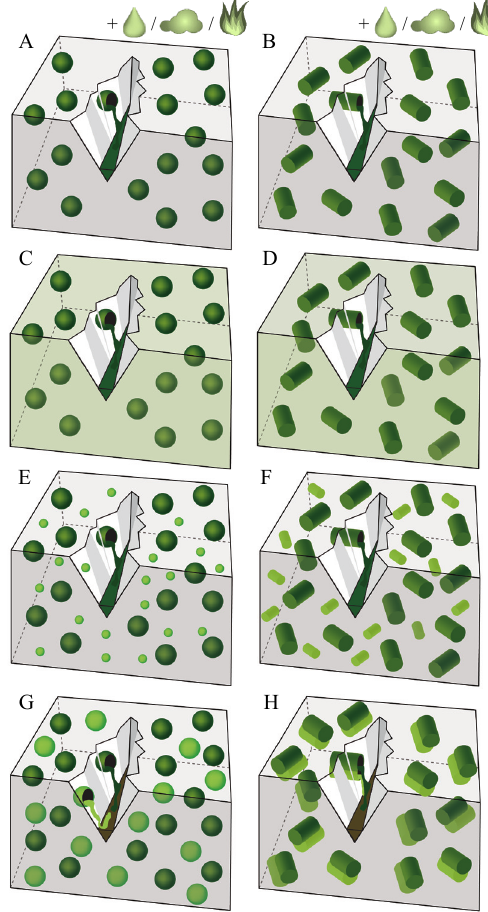
Figure 3. Capsule based self-healing approaches. Leakage of healing agent from the capsules into the crack due to gravitational and capillary forces. Reaction of spherical/cylindrical encapsulated agent (dark colored inclusions) upon contact with ( A , B ) moisture or air or due to heating; ( C , D ) the cementitious matrix; ( E , F ) a second component present in the matrix (small, light colored inclusions) or ( G , H ) a second component provided by additional capsules (big, light colored